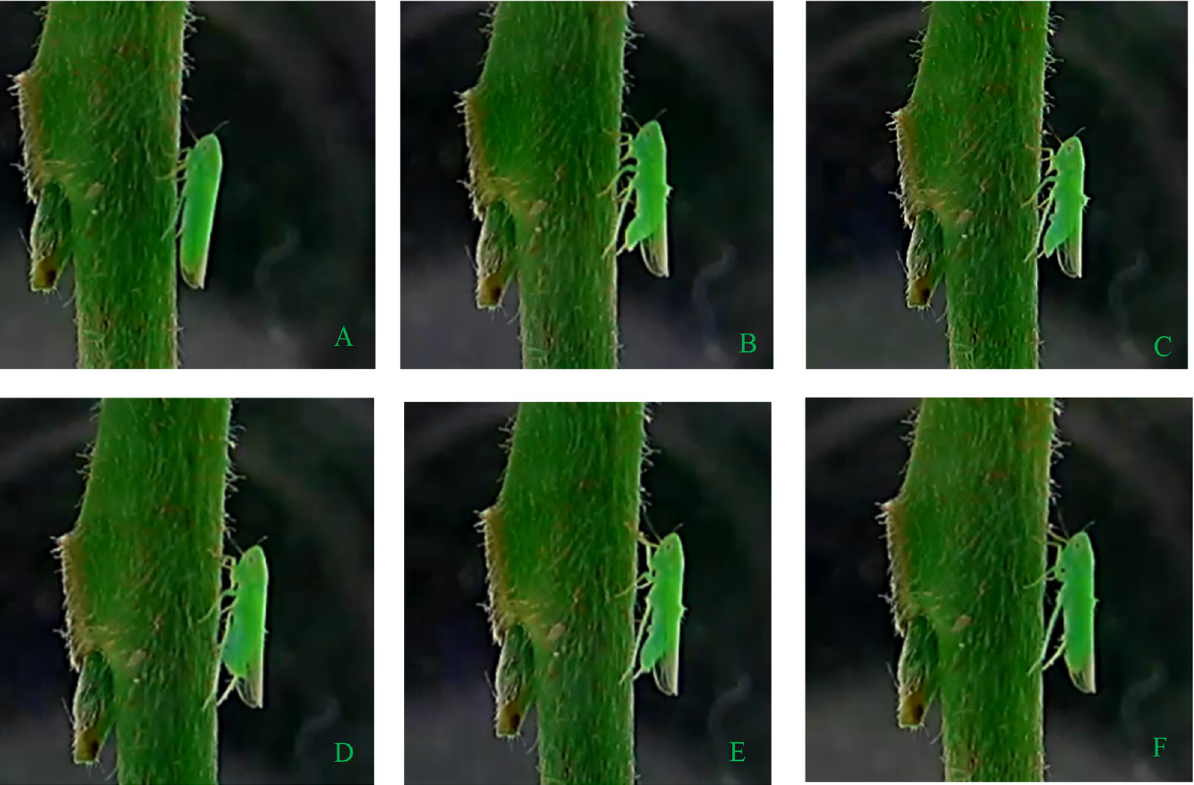
Fig 4. Oviposition behavior of the Matsumurasca onukii female adult. (A) Stopping feeding; (B) Abdomen bending and ovipositor extending; (C) Adjusting body gesture and penetrating epidermis; (D) Releasing an egg; (E) Ovipositor withdrawal; (F) Resting.